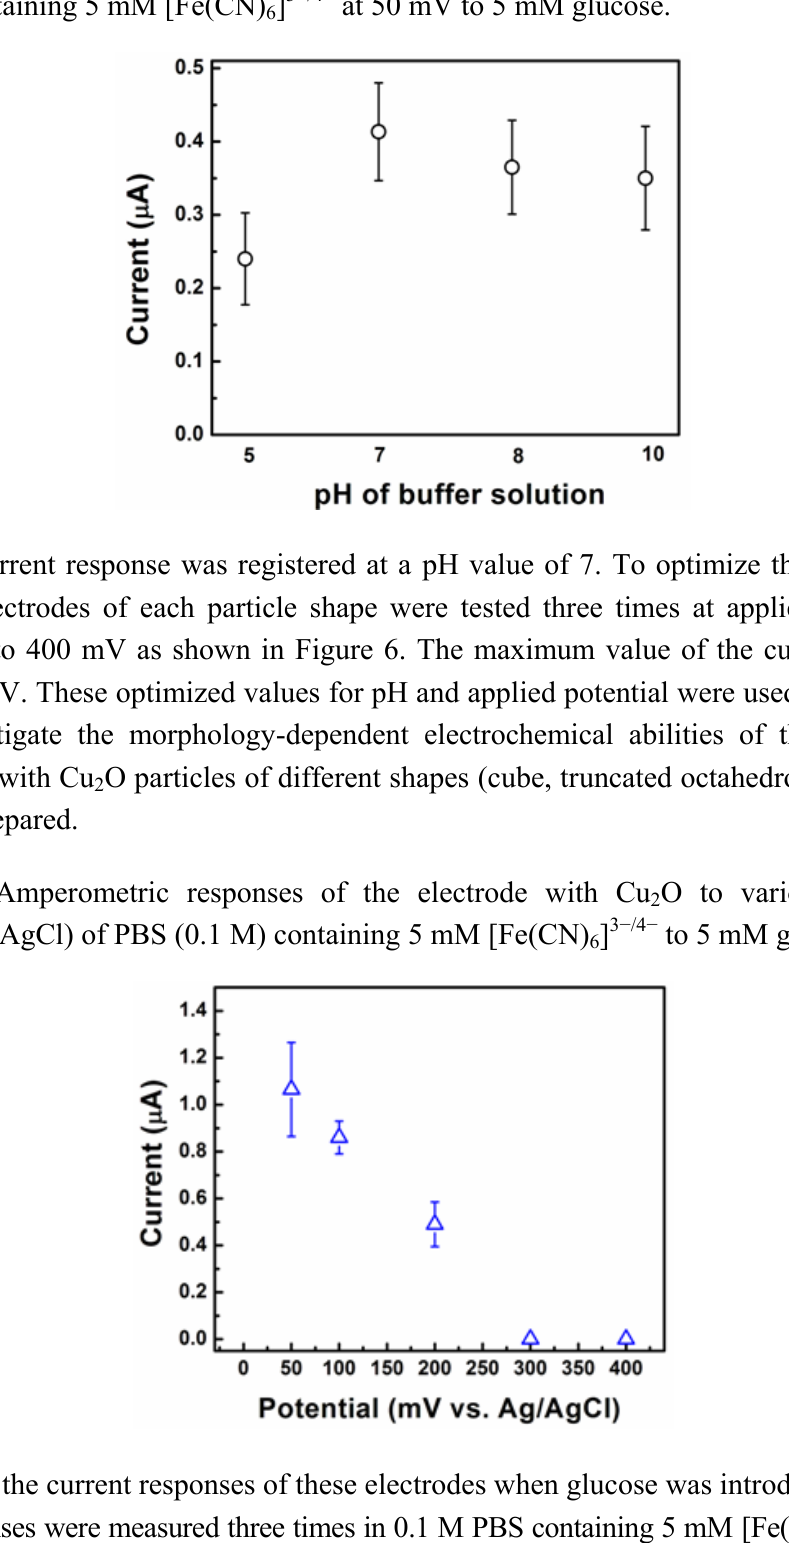
Figure 5. Amperometric responses of the electrode with Cu (0.1 M) containing 5 mM [Fe(CN)